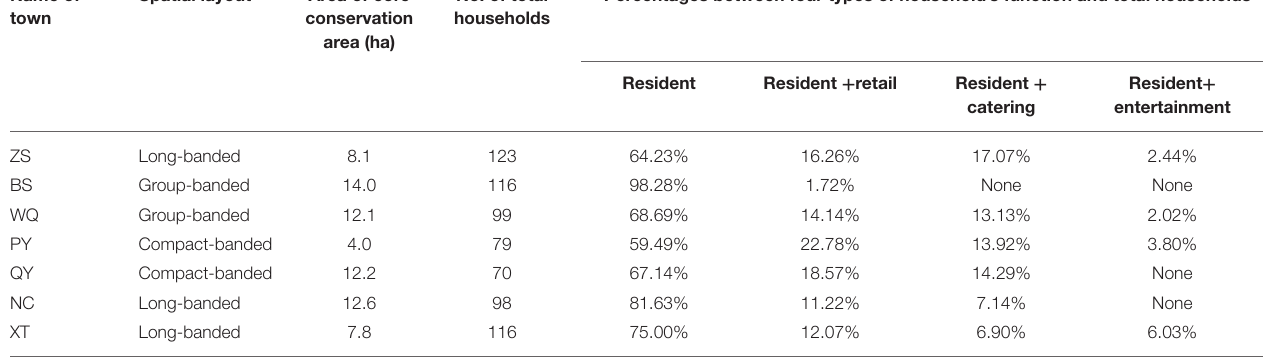
TABLE 1 | Brief profiles of the seven studied samples, namely, Zhongshan, Baisha, Wenquan, Pianyan, Qingyang, Ningchang, and Xituo towns. Name of town